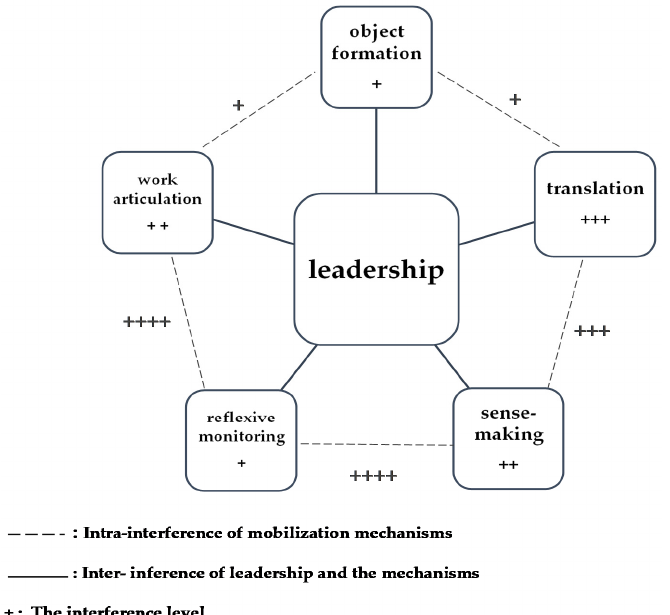
Figure 3. General representation of interference on mobilization mechanisms and leadership ele- ments. The + signs represent interference levels, the power of interferences seen is reflected by the number of + signs such as ++, +++ or ++++. Dashed lines represent intra-interference mechanisms. Full lines represent the inter-interference of leadership and